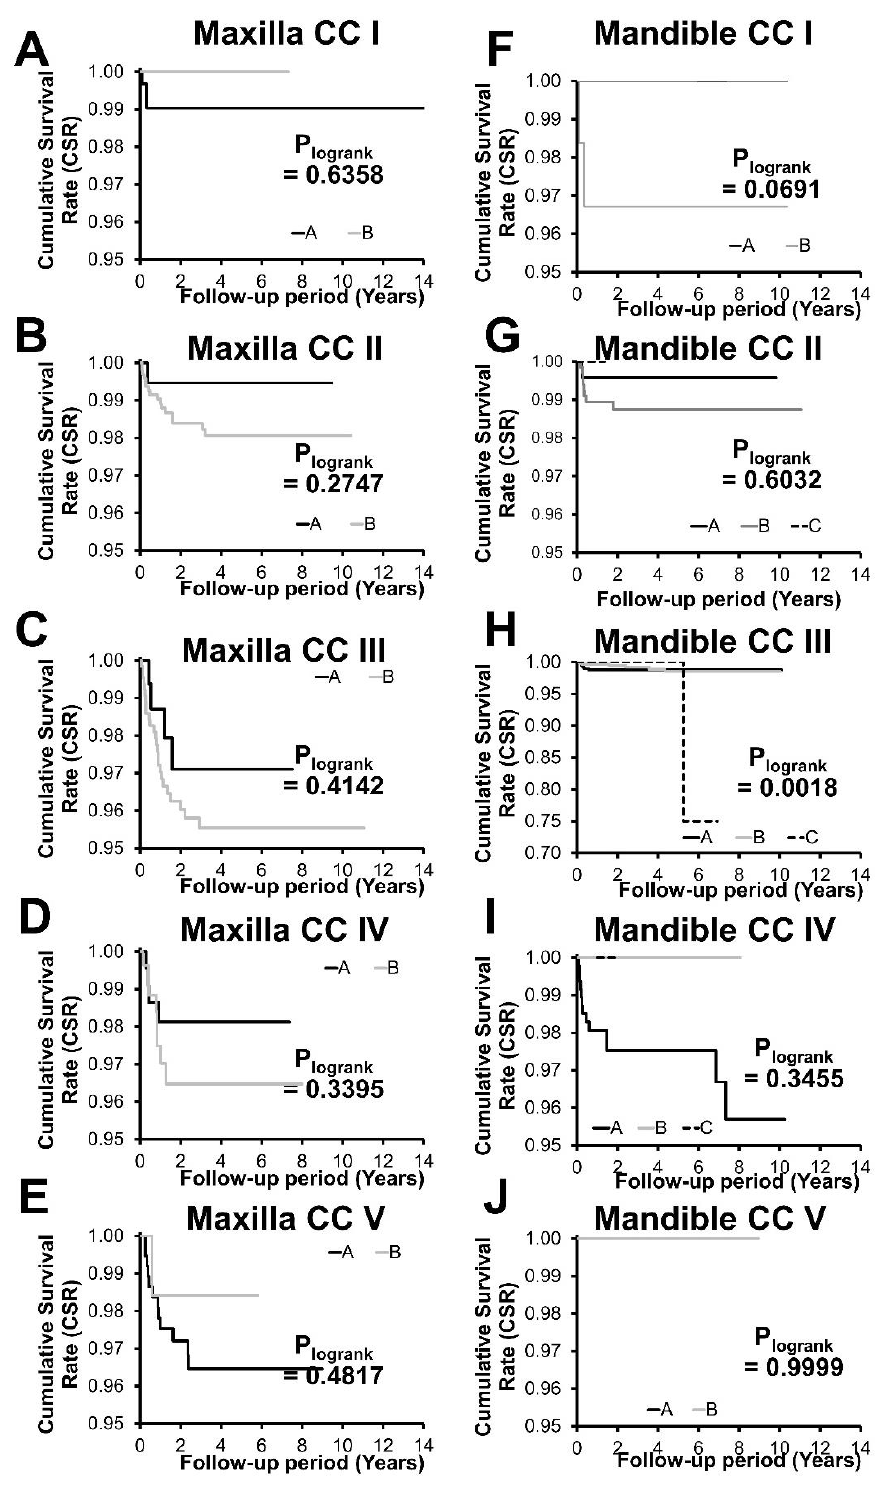
Figure 4. Kaplan – Meier plot, cumulative survival rates of maxillary ( A – E ) and mandibular ( F – J ) Figure 4. Kaplan–Meier plot, cumulative survival rates of maxillary ( A – E ) and mandibular implants placed in individual anatomical classifications (CC I – V, individual graphs) as a function ( F – J ) implants placed in individual anatomical classifications (CC I–V, individual graphs) as a func- of TOs ( A – C ). tion of TOs ( A – C